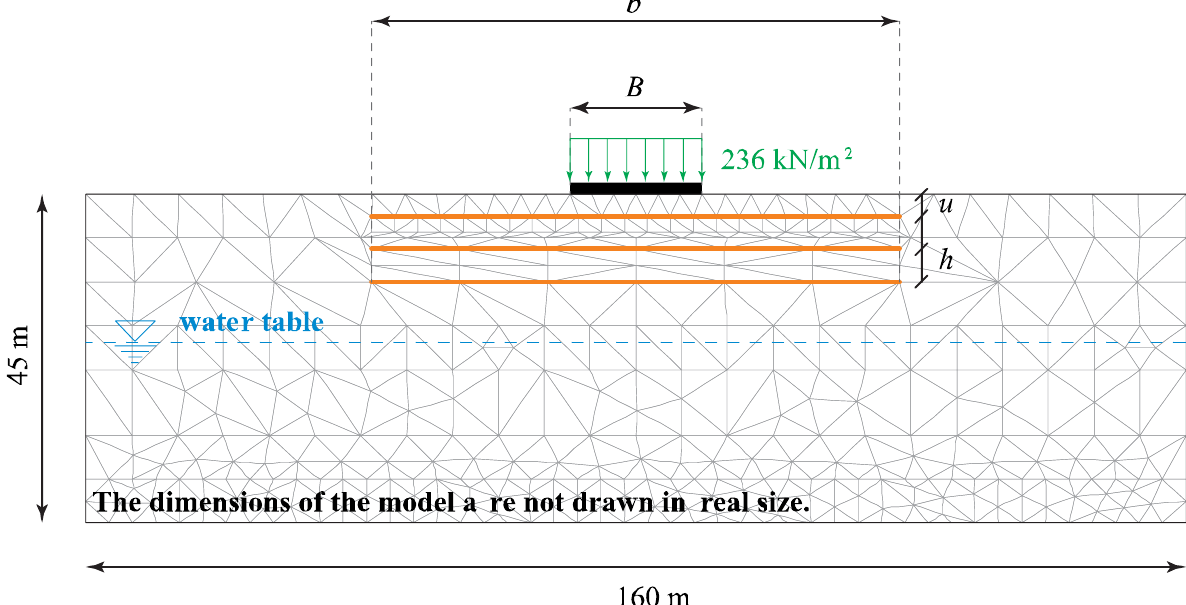
Figure 2. Finite element meshes with boundary